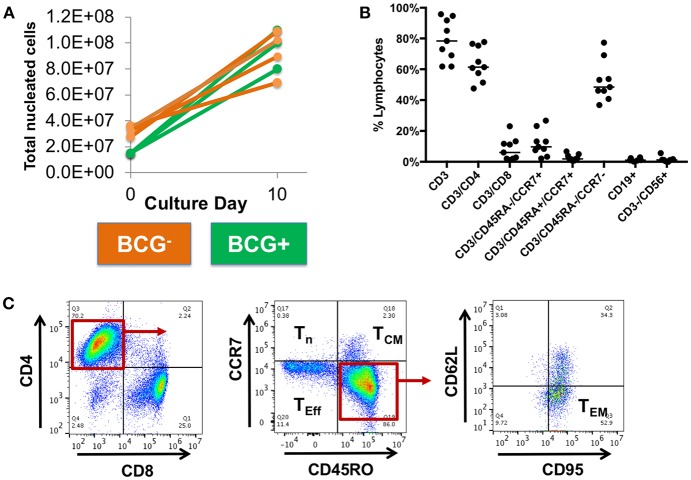
Expanded MSTs are mostly CD4+ effectors. (A) Mycobacterial-specific T cells expanded during culture with a mean fold-expansion of 4.4. BCG- = BCG non-immunized; BCG+ = BCG immunized. (B) Surface phenotyping of MSTs following expansion showed a predominance of CD4+ T cells with large effector memory population and smaller central memory population. Lines, median value. (C) Example plots from MSTs expanded from Donor 9 show a large CD4+ effector memory (TEM) population and smaller effector (Teff) and central memory (Tcm) population, with minimal naïve T cells (Tn).